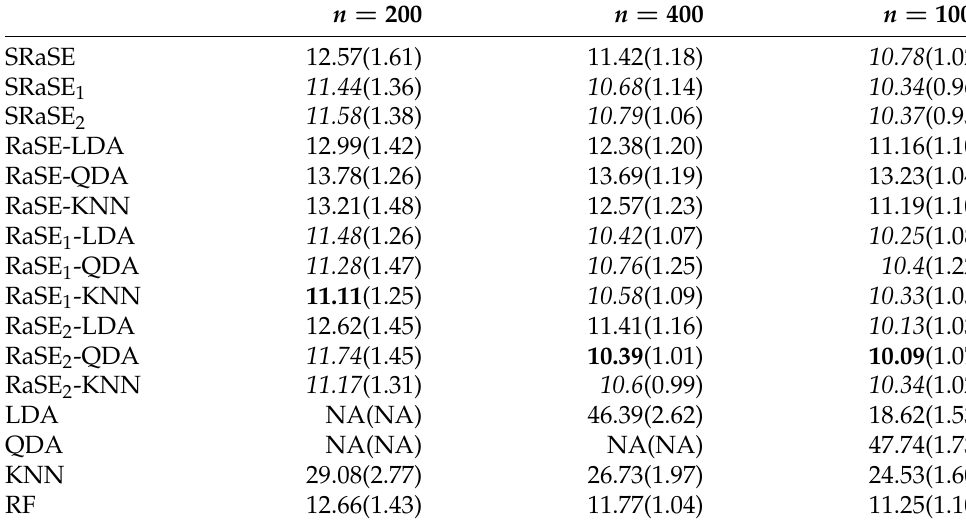
Table 1. Summary of test classification error rates for each classifier under various sample sizes over 200 repetitions in Model 1 (LDA). The results are presented as mean values with the standard deviation values in parentheses. Here, the best performing method in each column is highlighted in bold and the methods that are within one standard deviation away are highlighted in